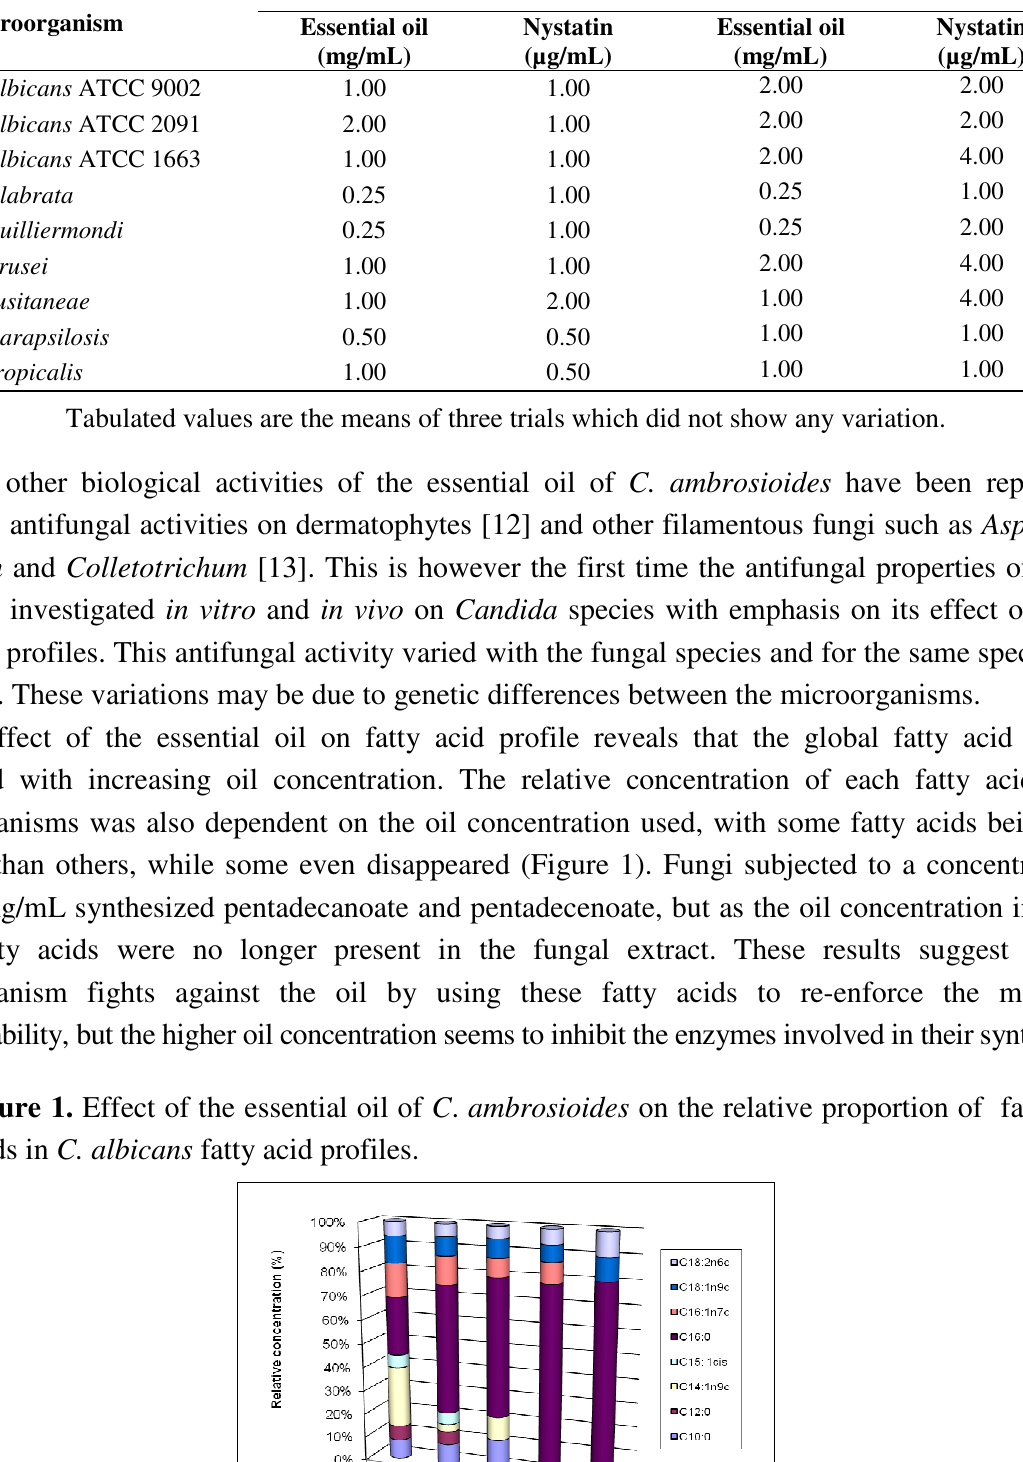
Unsaturated-to-saturated fatty acid ratio: 0 mg/mL (1.6), 0.625 mg/mL (0.5), 1.25 mg/mL (0.4), 2.5 mg/mL (0.3), 5 mg/mL